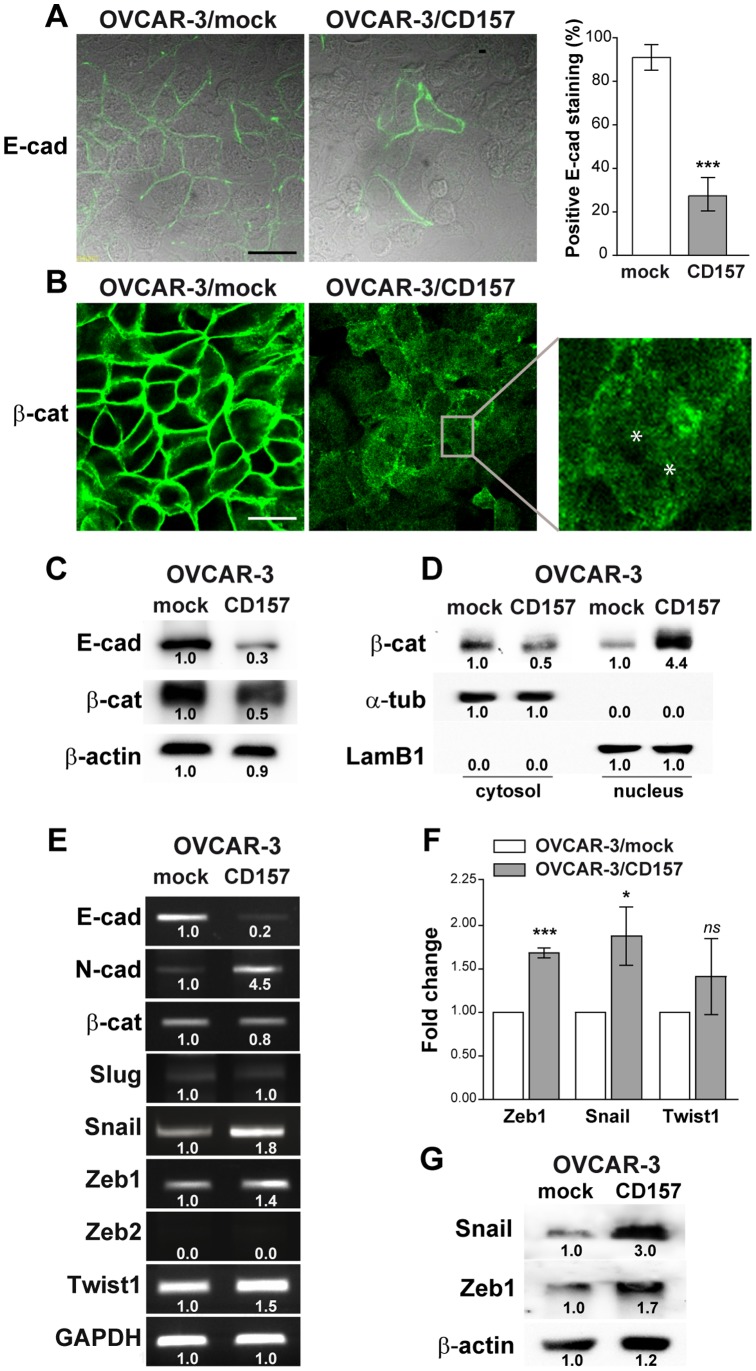
CD157 overexpression alters the expression of epithelial and mesenchymal markers.(A) Confocal microscopy analysis of E-cadherin and (B) β-catenin expression in OVCAR-3/CD157 and mock cells. Cells were grown on a gelatin-coated coverslip, fixed, permeabilized and stained with anti-E-cadherin, and anti-β-catenin antibodies followed by secondary Alexa Fluor-488-labelled antibody. Samples were analyzed with an Olympus FV300 laser scanning confocal microscope and by Nomarski differential interference contrast (DIC) optics. For E-cadherin, a fluorescence image merged with DIC image is shown (scale bar: 50 µM). Semiquantitative analysis of E-cadherin junctional staining was determined by counting a minimum of 10 fields/sample (at least 200 cells overall) and scoring as positive cells with two remaining fluorescent intercellular borders. For β-catenin, a fluorescent image is shown. Inset: amplified view of an individual OVCAR-3/CD157 cell exhibiting diffuse β-catenin staining in the plan of focus cutting through the nucleus. Asterisks correspond to nucleoli. (C) Western blotting for E-cadherin and β-catenin in OVCAR-3/CD157 and mock cells. Densitometry quantifies the expression level of E-cadherin and β-catenin relative to β-actin. (D) β-catenin levels in nuclear and cytoplasmic fractions of OVCAR-3/mock and OVCAR-3/CD157 cells were determined by western blot analysis. α-tubulin and lamin B1 (LamB1) were used as cytoplasmic and nuclear loading controls, respectively. Densitometry quantifies the expression level of β-catenin relative to the proper control. (E) sqRT-PCR for E-cadherin, N-cadherin, β-catenin and for E-cadherin transcriptional repressors in OVCAR-3/CD157 and mock cells. Densitometry quantifies the levels of expression of E-cadherin repressors relative to GADPH. (F) qRT-PCR for Zeb1, Snail and Twist1. The comparative CT method was used to determine gene expression in CD157-transfected cells relative to the value observed in the mock cells, using TBP as normalization control. Histograms report the means ± SEM of three qRT–PCR independent experiments, each conducted in triplicate. *P<0.05, ***P<0.001; ns, not significant; two-tailed t test. (G) Western blot analysis showing the level for Snail and Zeb1 in OVCAR-3/mock and OVCAR-3/CD157 cells. Densitometry quantifies the expression level of both proteins relative to β-actin. Results shown in each panel are representative of three independent experiments with similar results.